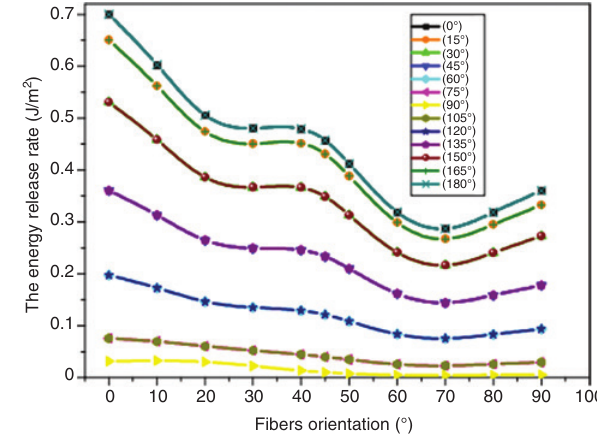
Figure 6: Contour of the constraint V. Mises equivalent to 30 ° fiber orientations in the case of displacement along the Y axis (U2 = 0).